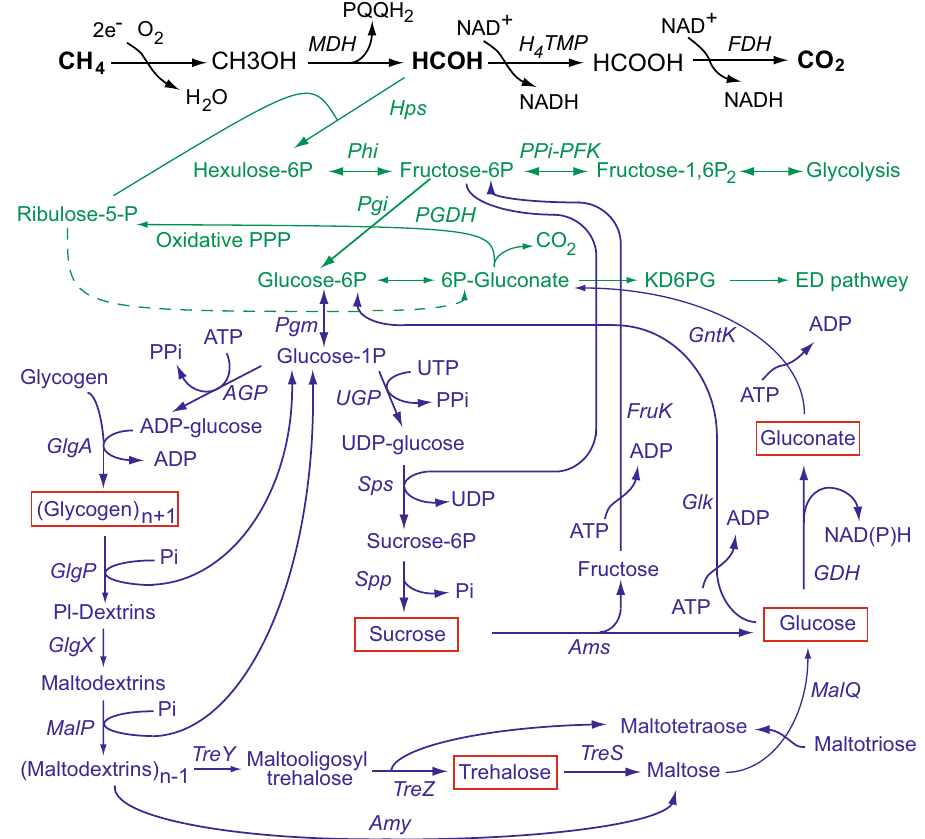
Figure 1. Schematic pathways for glycogen synthesis and degradation in Mtm. alcaliphilum 20Z. The methane oxidation reactions are black colored, the carbon assimilation pathways are green, the carbohydrate metabolism reactions are blue. MMO, methane monooxygenase; MDH, methanol dehydrogenase; FDH, formate dehydrogenase; HPS, hexulose-phosphate synthase; HPI, hexulosephosphate isomerase; PGI, phosphoglucose isomerase; PGM, phosphoglucose mutase; Glk, glucokinase; GntK, gluconate kinase; FruK, fructokinase; UGP, uridine glucopyrophosphorylase; AGP, adenosine glucopyrophosphorylase; GlgA, glycogen synthase; GlgP, glycogen phosphorylase; GlgX, debranching enzyme; TreY, maltooligosyl trehalose synthase; TreZ, trehalohydrolase; MalP, maltodextrin phosphorylases; TreS, trehalose synthase; MalQ, alpha-glucanotransferase; Ams, amylosucrase; Sps, sucrose-phosphate synthase; Spp, sucrose-phosphate phosphatase; GDH, glucose dehydrogenase; Gnl, lactonase. The genome analysis was carried out using NCBI and MicroScope databases (http:// www. ncbi. nlm. nih. gov, https:// mage. genos cope. cns.